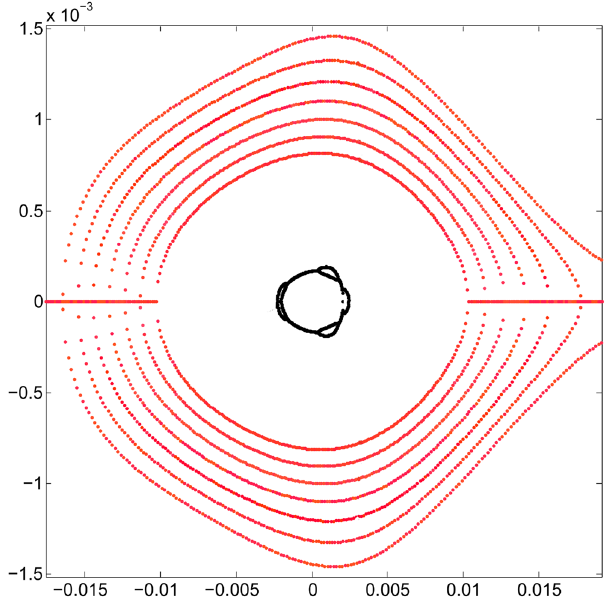
Figure 10. Structure of the phase space ( x , p x ) showing the dynamic aperture estimated by the quasi-invariant method, after optimization at x 0 = 10 mm, with the set of sextupoles { S 2 } . The quasi-invariant method predicts stability for amplitudes of the order of 15 mm. For comparison purposes, the resonance structure (Fig. 3) provided by the initial set { S 0 } of sextupoles is included in black.